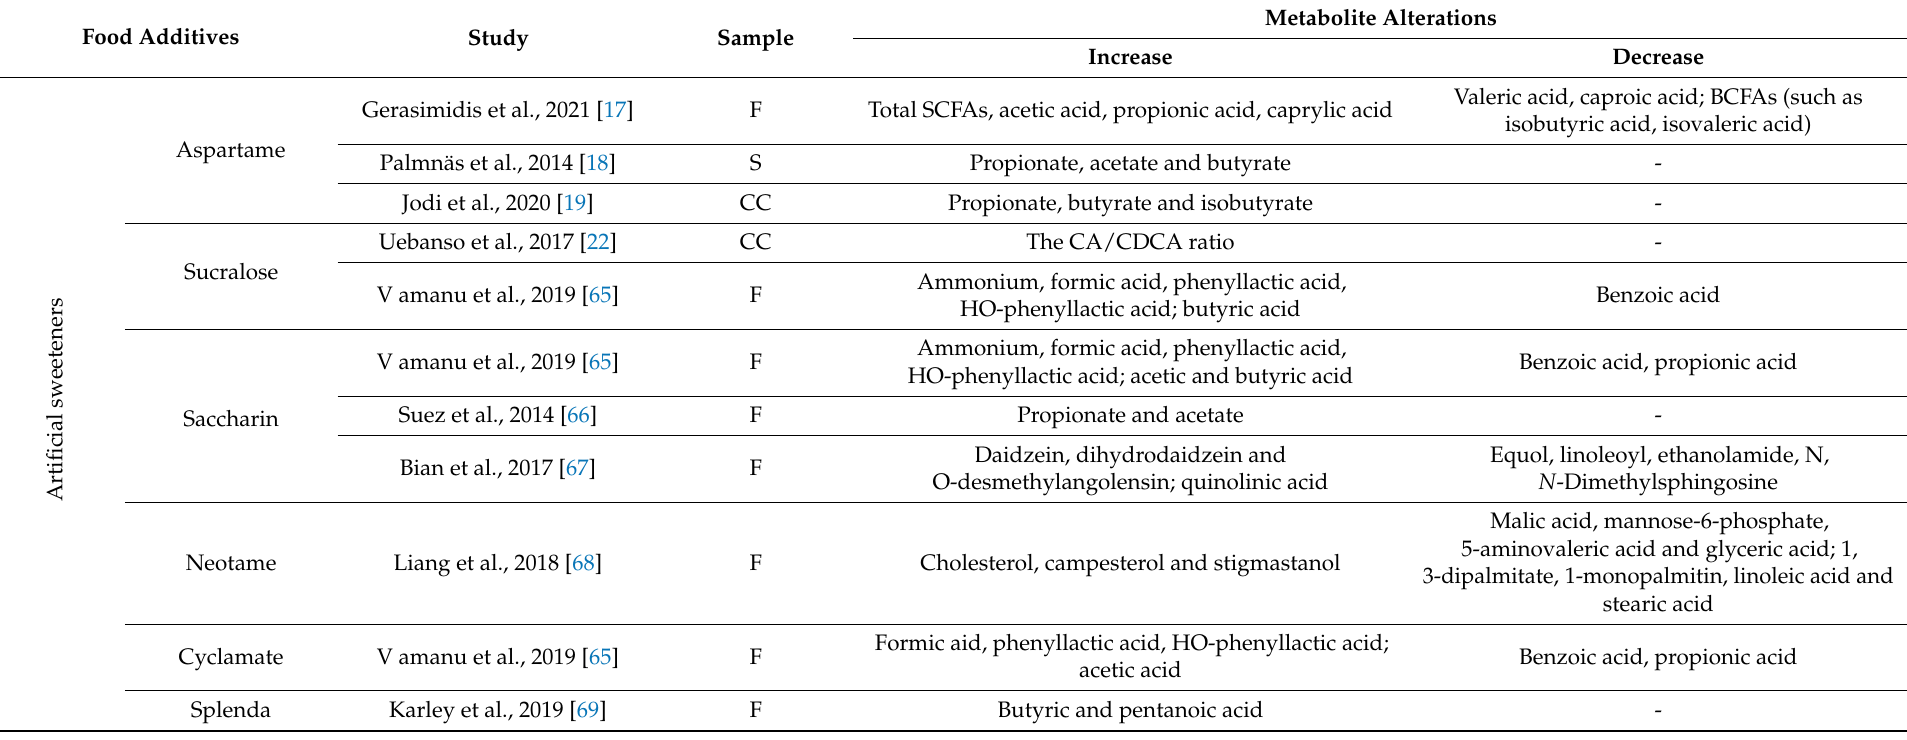
Table 2. The influence of various food additives on the intestinal